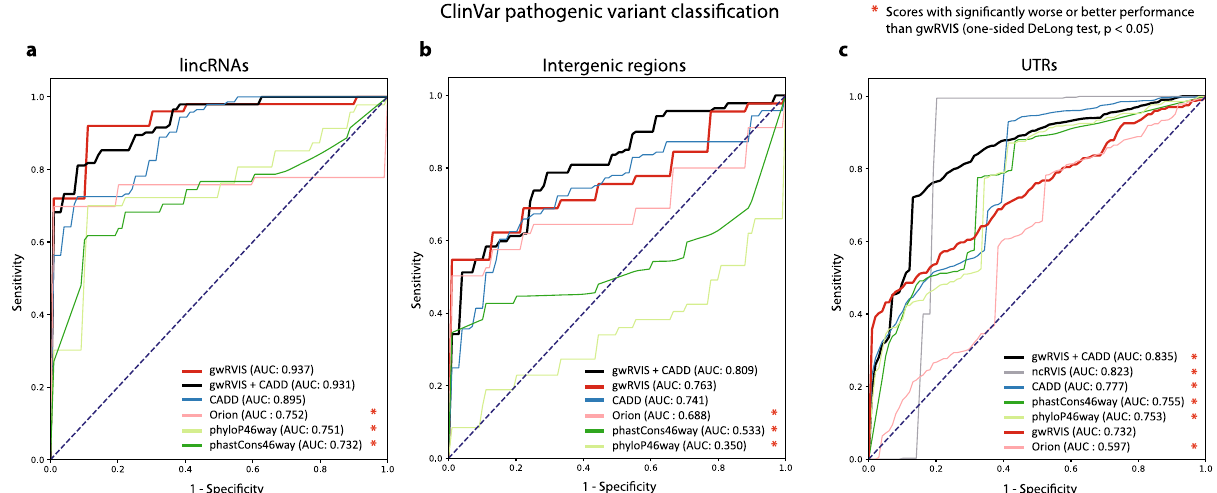
Fig. 3 Predictive power of gwRVIS for pathogenic variant classi fi cation. Mean ROC curves (with fi vefold cross-validation) from gwRVIS benchmarking against CADD, phastCons (46-way), phyloP (46 way), and Orion, during ClinVar-pathogenic vs. denovodb-benign variant classi fi cation for three noncoding genomic classes: a lincRNAs, b intergenic regions, and c UTRs. The combined performance of gwRVIS with CADD is also shown. ncRVIS is included in the benchmarking of the UTR regions ( c ), as a robust score speci fi cally designed for the UTR genomic class. One-sided DeLong ’ s tests have been performed to assess the statistical signi fi cance of the differences in predictive power between gwRVIS and the rest of genome-wide